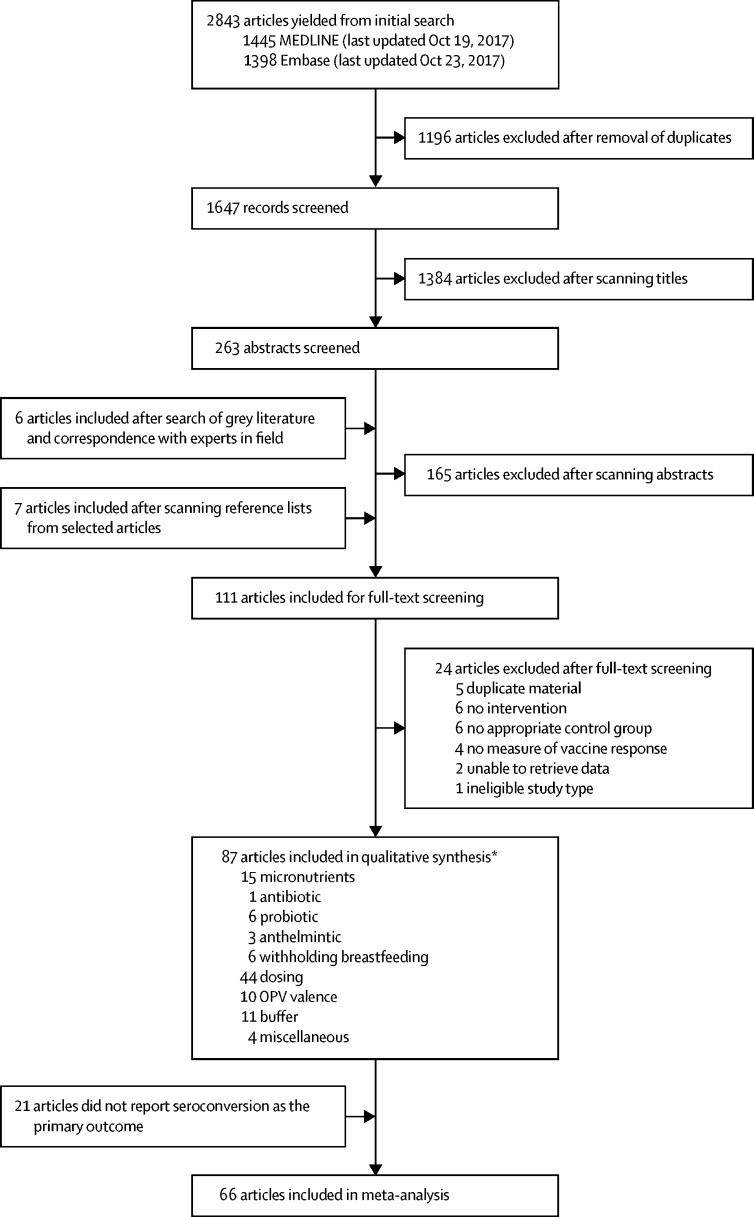
Study selectionOPV=oral polio vaccine. *Studies exploring multiple interventions are duplicated within this breakdown.